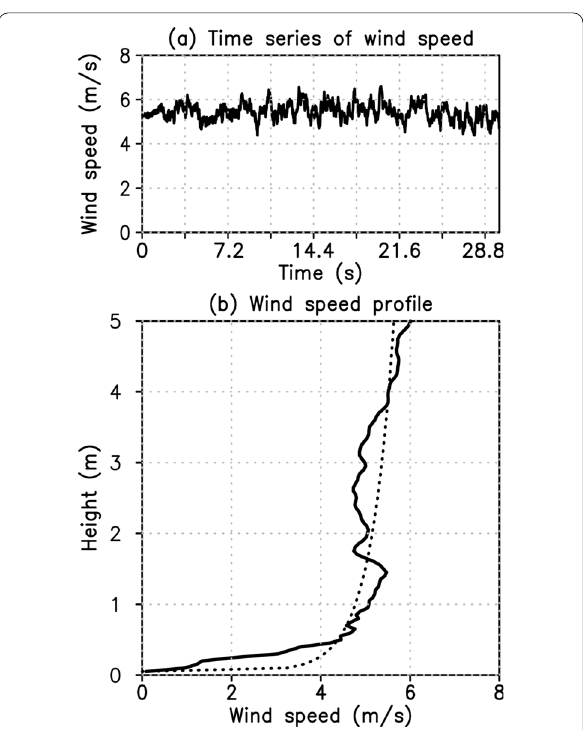
Fig. 4 a Time series of wind speed for the no-fence experiment at the center of the calculation domain from 0 to 30 s. b Vertical wind speed profile for the no fence experiment at ( x , y , t ) (3.5 m, 2.5 m, = 0 s) (dotted line) and at ( x , y , t ) (3.5 m, 2.5 m, 30 s) (solid =